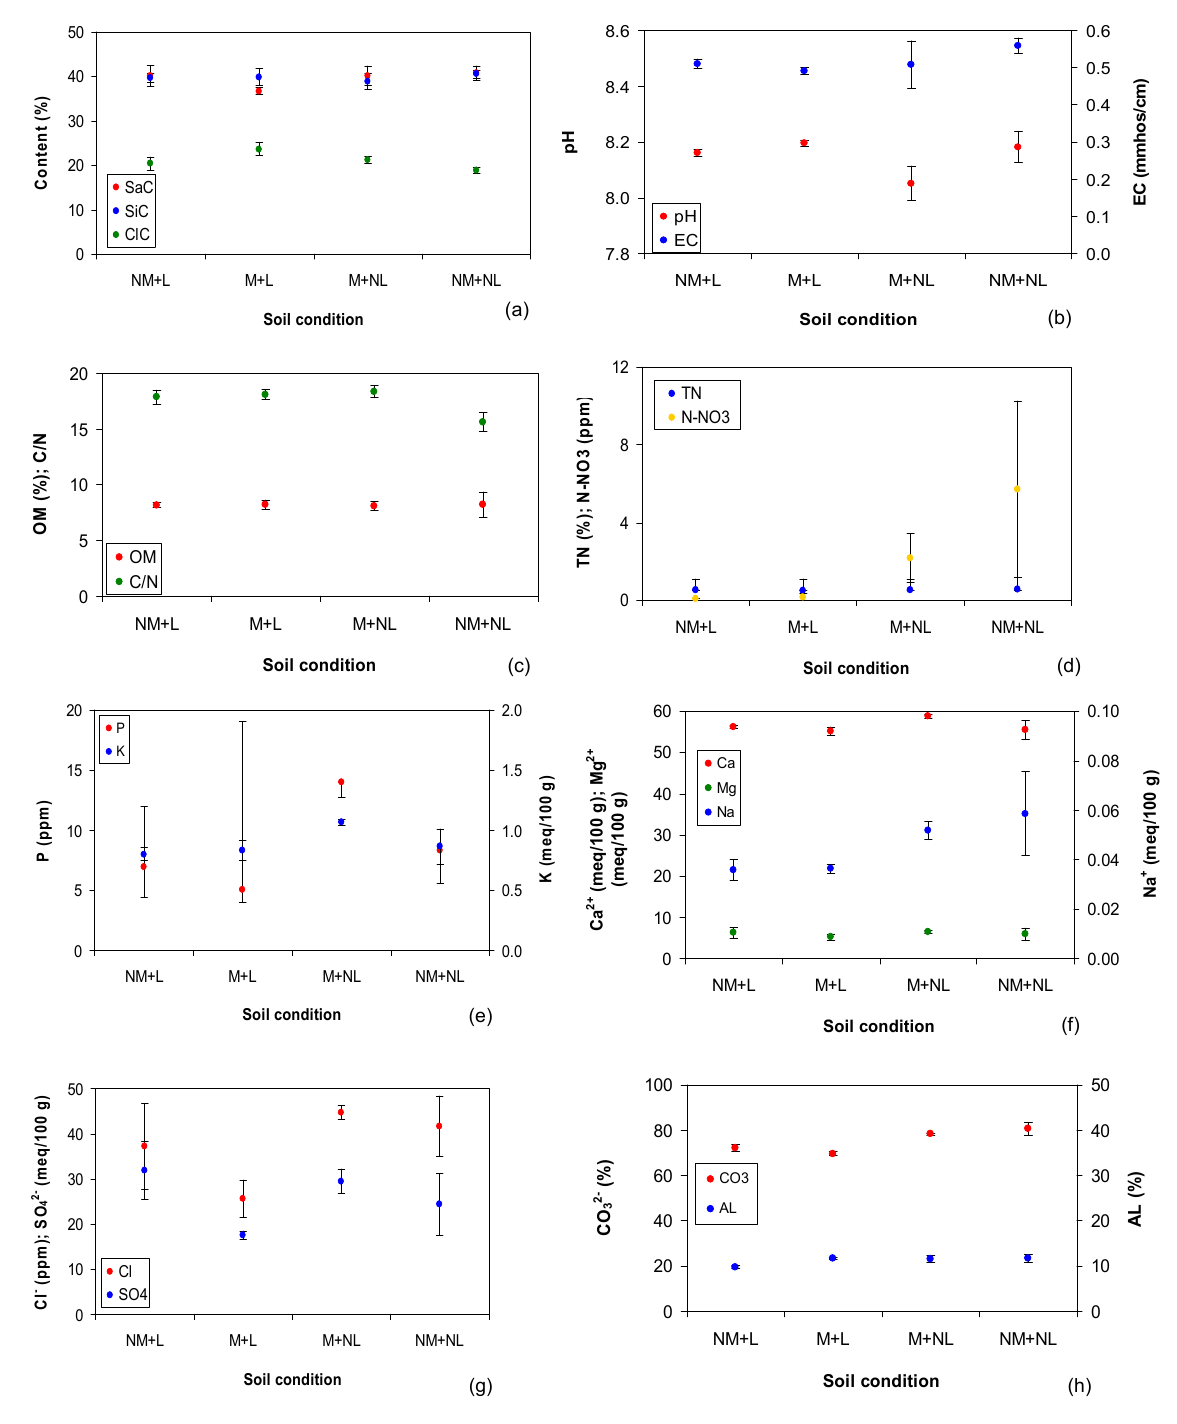
Figure 2. Main chemical properties of soils (mean ± standard error) supporting growth of Pinus halepensis Mill. in plots subjected to four treatments in Sierra de Los Donceles forest (Liétor, Castilla La Mancha, Spain). Legend: M + L = mulching + logging; NM + L = no mulching + logging; NM + NL = no mulching + no logging; M + NL = mulching + no logging; ( a ) SaC = sand content; SiC = silt content; ClC = Clay content; ( b ) EC = electrical conductivity; pH; ( c ) OM = organic matter; C/N= Carbon to nitrogen ratio; ( d ) TN = total nitrogen; N ‐ NO 3 = nitric nitrogen; ( e ) P = phosphorous; K + = potassium; ( f ) Na + = sodium; Ca 2+ = calcium; Mg 2+ = magnesium; ( g ) Cl − = chloride; SO 42 − = sulphates; ( h ) CO 32 − = carbonates; AL = active limestone. The differences in pH and EC were also not significant (F = 2.463, p = 0.113 for pH, and F = 0.716, p = 0.561 for EC). The pH was higher in M + L plots (8.2 ± 0.01) and lower in